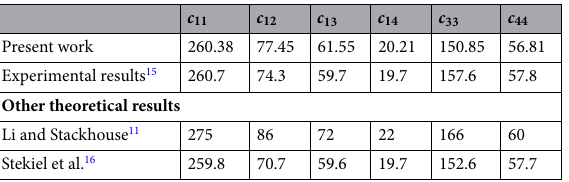
Table 2. Calculated elastic constants ( c ij , in GPa) of magnesite, compared with the experimental and previous theoretical results at 0